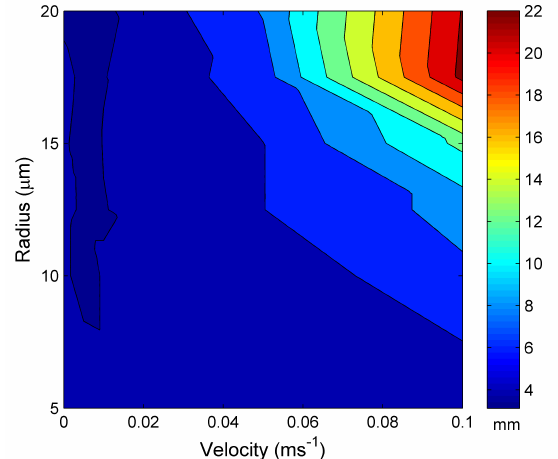
Figure 9. The distance taken to reach steady-state length vs. the water hole radius and water input velocity at 90 ◦ C .